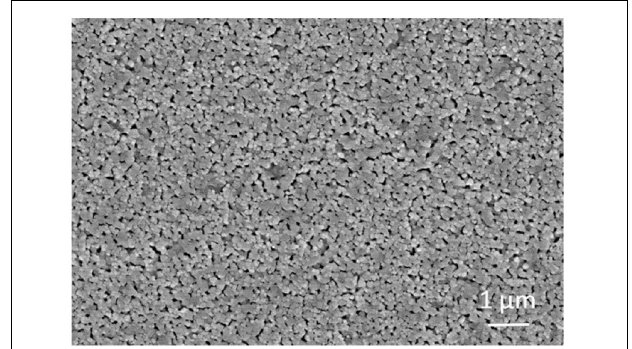
FIGURE 3 | A typical SEM image of the NiO nanoparticle thin film on YSZ plate after sintering.